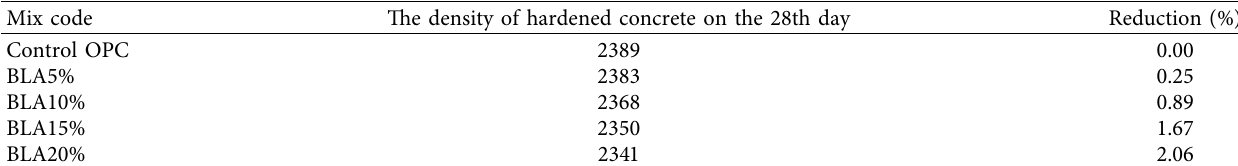
Table 9: Density of hardened